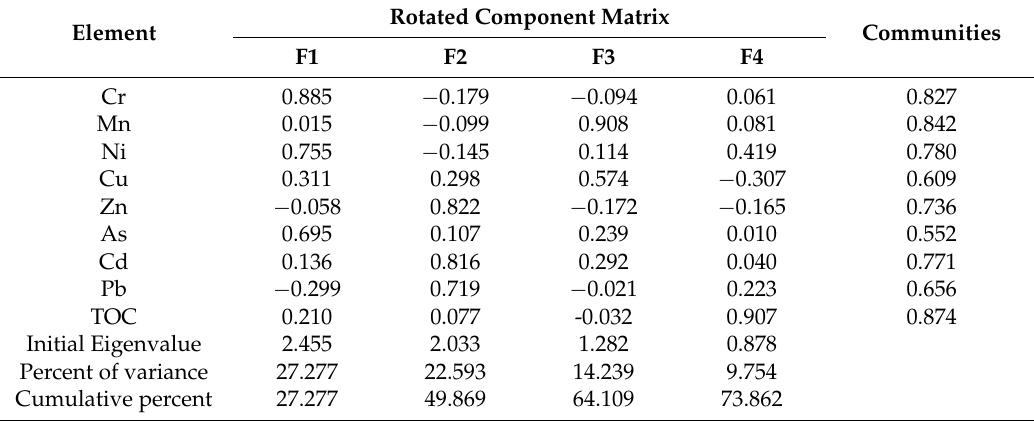
Table 4. Rotated component matrix for 8 HM concentrations and TOC